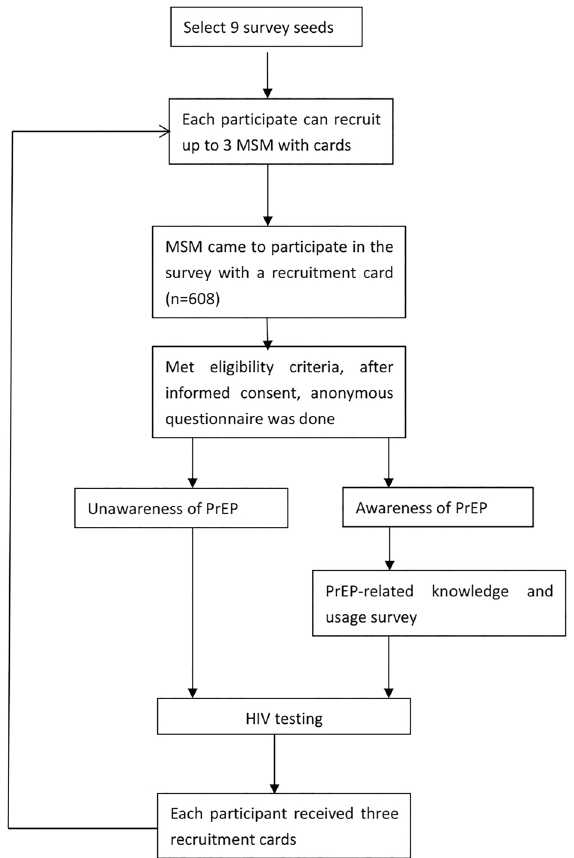
Figure 1. Flow chart of eligibility and